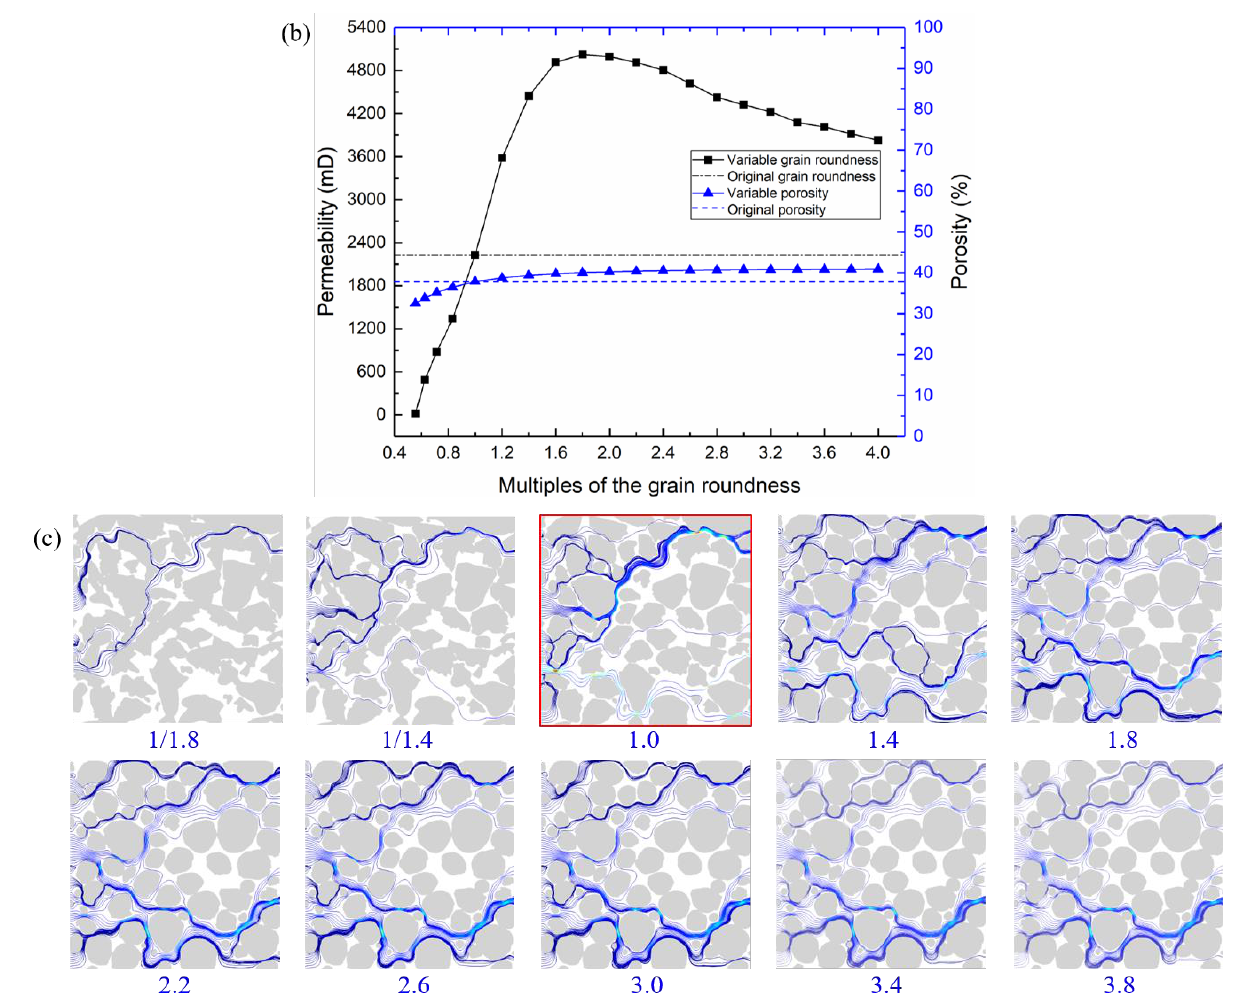
Figure 15. Influence of grain roundness on permeability. ( a ) Pore models with different grain roundness; ( b ) porosity and permeability of pore models with different grain roundness; ( c ) flow paths and velocity of pore models with different grain roundness.